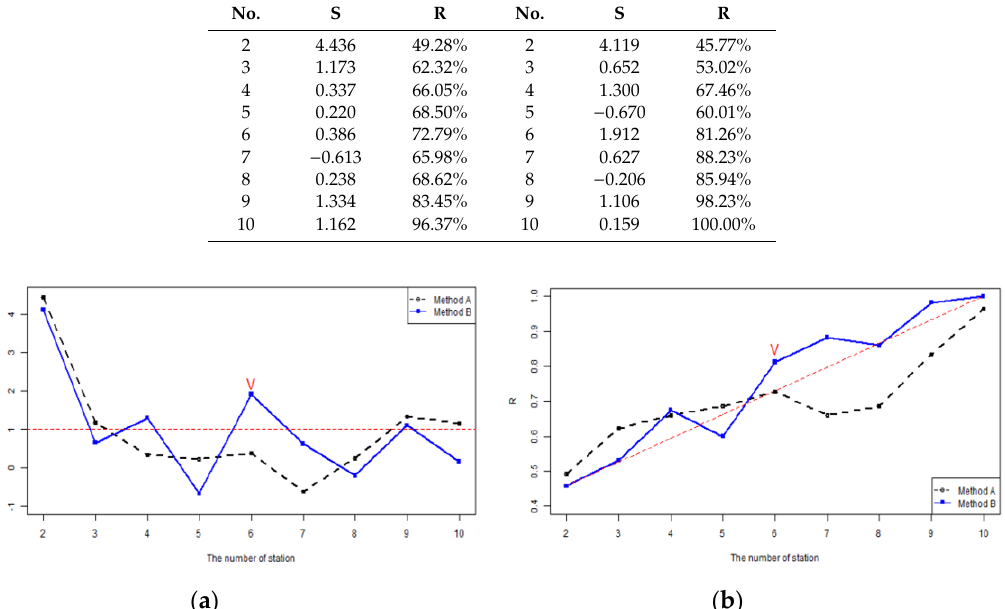
Figure 6. Optimal number of rain gauge networks using RMSE: ( a ) reduction of RMSE (S); ( b ) ratio of RMSE (R). Table 5. RMSE result to determine the optimal number of stations for the rain gauge network.